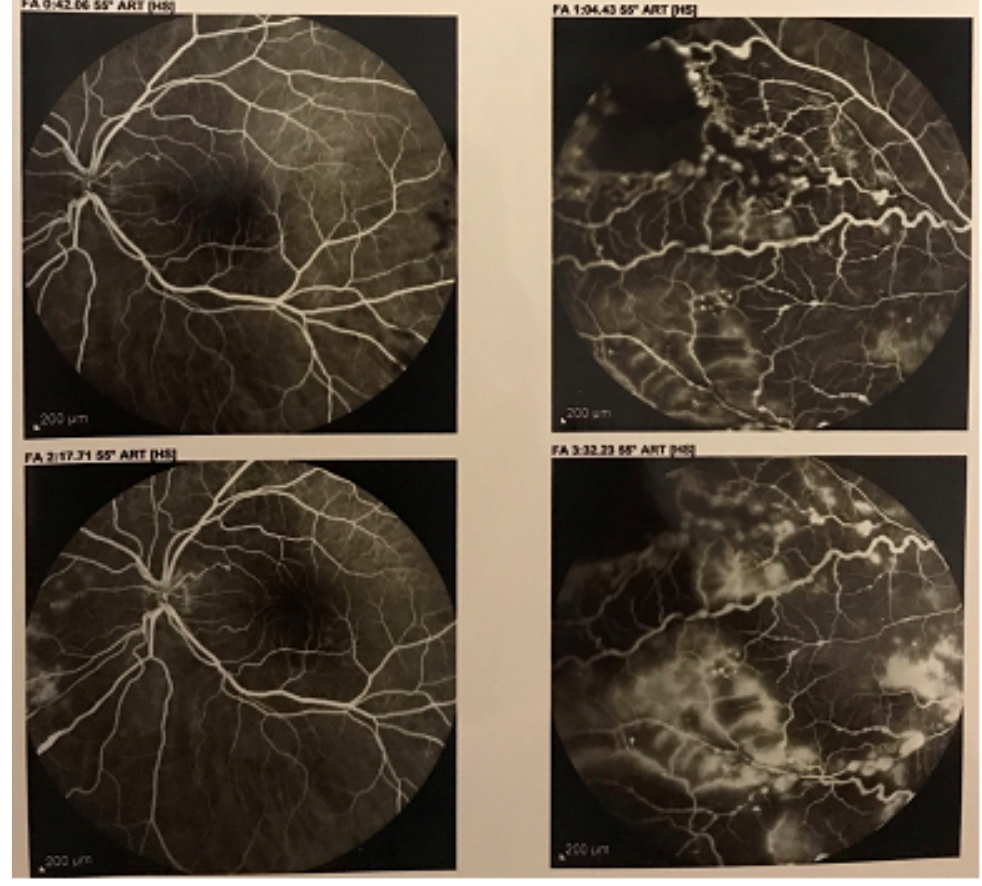
Figure 2. Fundus fluorescein angiography. Vascular tortuosity and fusiform aneurysms with leakage and non-perfusion areas in the mid-peripheral and peripheral regions.